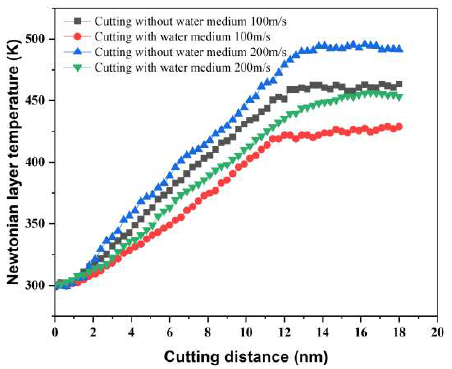
Figure 13. Temperature distribution at different cutting speeds.